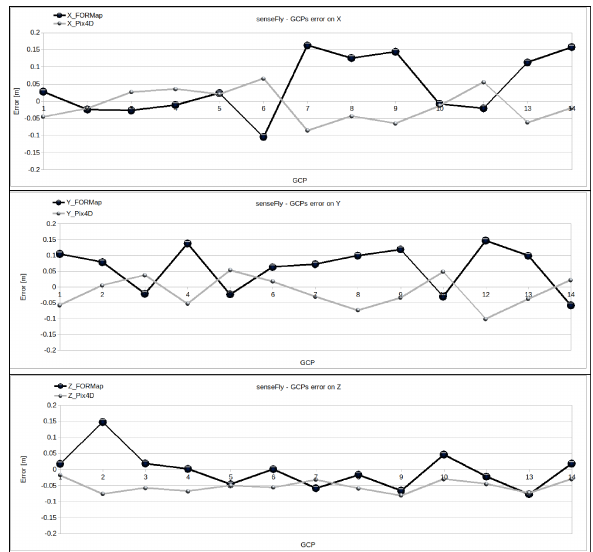
Figure 5. Accuracy assessment on GCPs of senseFly dataset. From the top : Euclidean distance, in X, in Y, in Z. Black line : FORMap, Grey line : Pix4D. The horizontal axis indexes the GCP number and the vertical axis is centered at 0 .